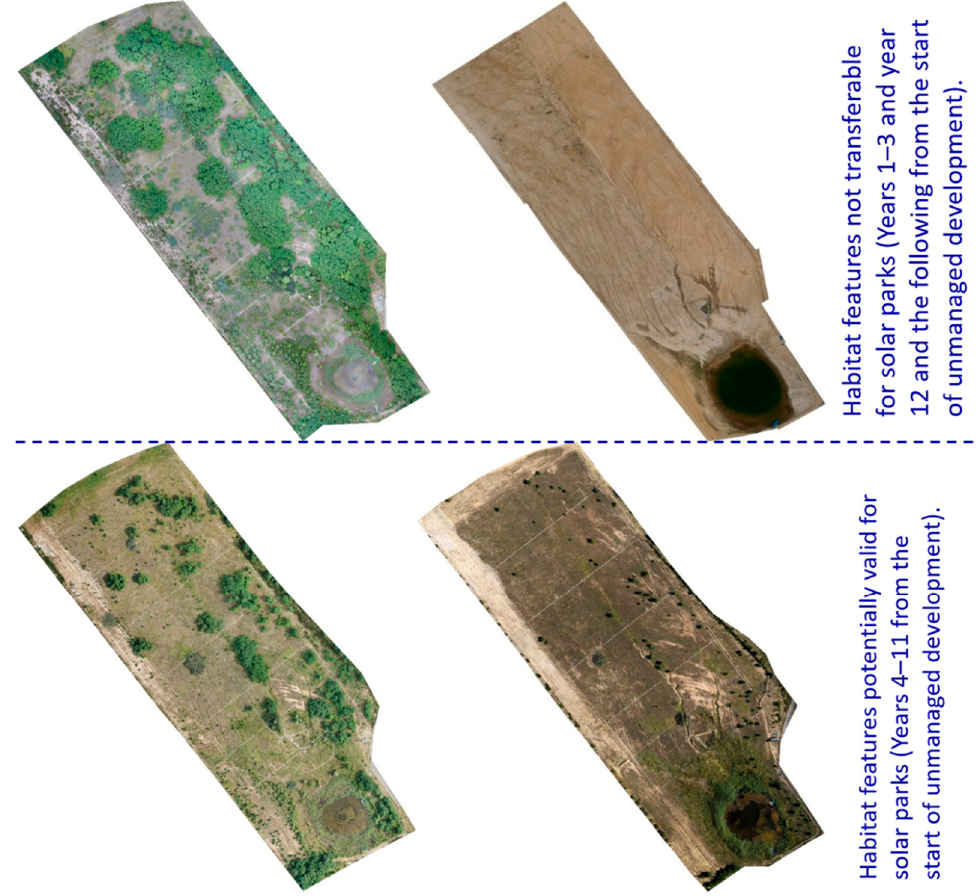
Figure 1. Development of the Hühnerwasser catchment, clockwise from top right—as bare ground in 2007 ( top right ), 2011 ( bottom right ), 2015 ( bottom left ), and 2020 ( top left ). Thanks to the Research Center Landscape Development and Mining Landscapes of the Brandenburg University of Technology Cottbus-Senftenberg for providing the aerial photos, each composed of many drone photos. North is always at the top. A scale bar cannot be given, but the spacing of the paths—which are particularly well visible as grey lines in the 2011 representation ( bottom right )—is 60 m, and 40 m when close to the